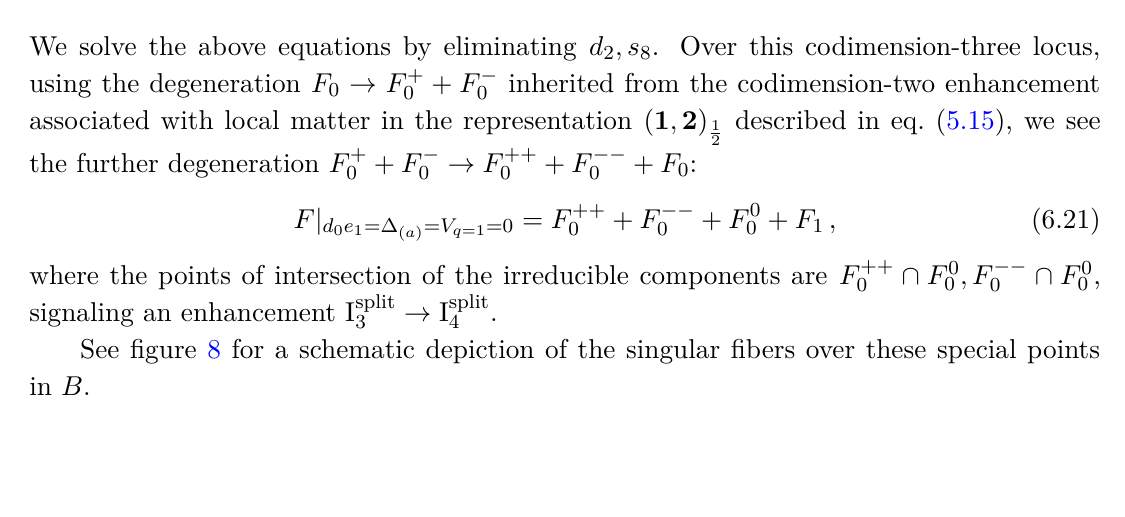
× ( 1 , 2 ) × ( 1 , 1 ) w 0 ¯1 w 00 ¯1 ¯1